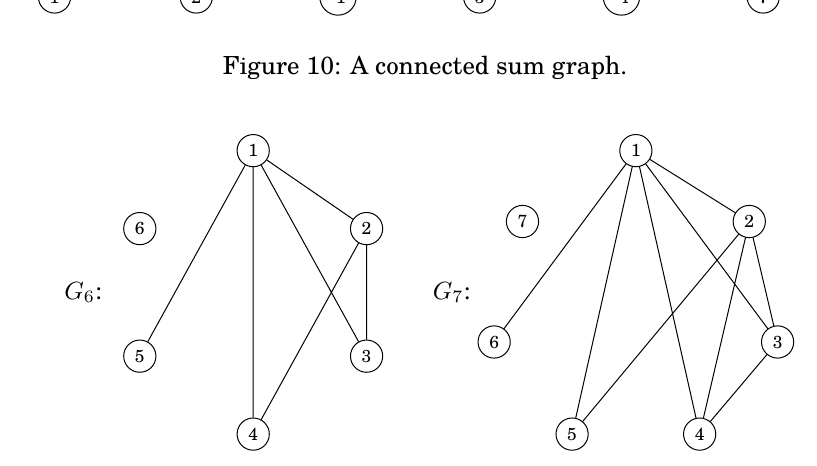
Figure 10: A connected sum graph.